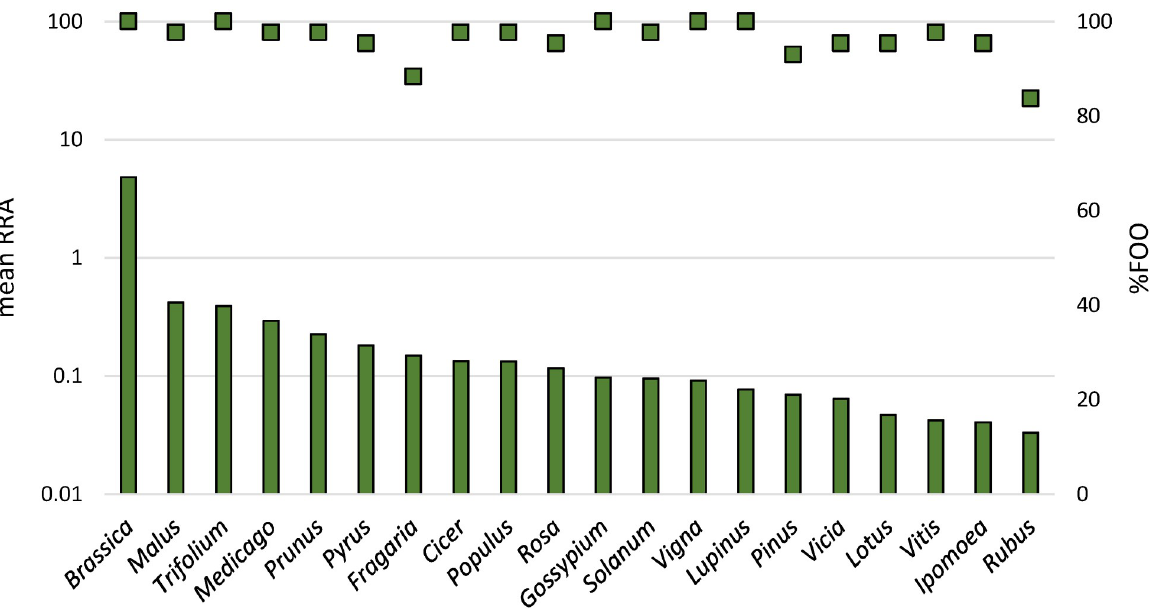
Fig 4. The relatively most abundant and frequent plant genera based on the DNA in honey samples. The twenty plant genera with the highest mean RRA based on metagenomics (y-axis on the left), shown with %FOO (y-axis on the right). Note the logarithmic scale used for